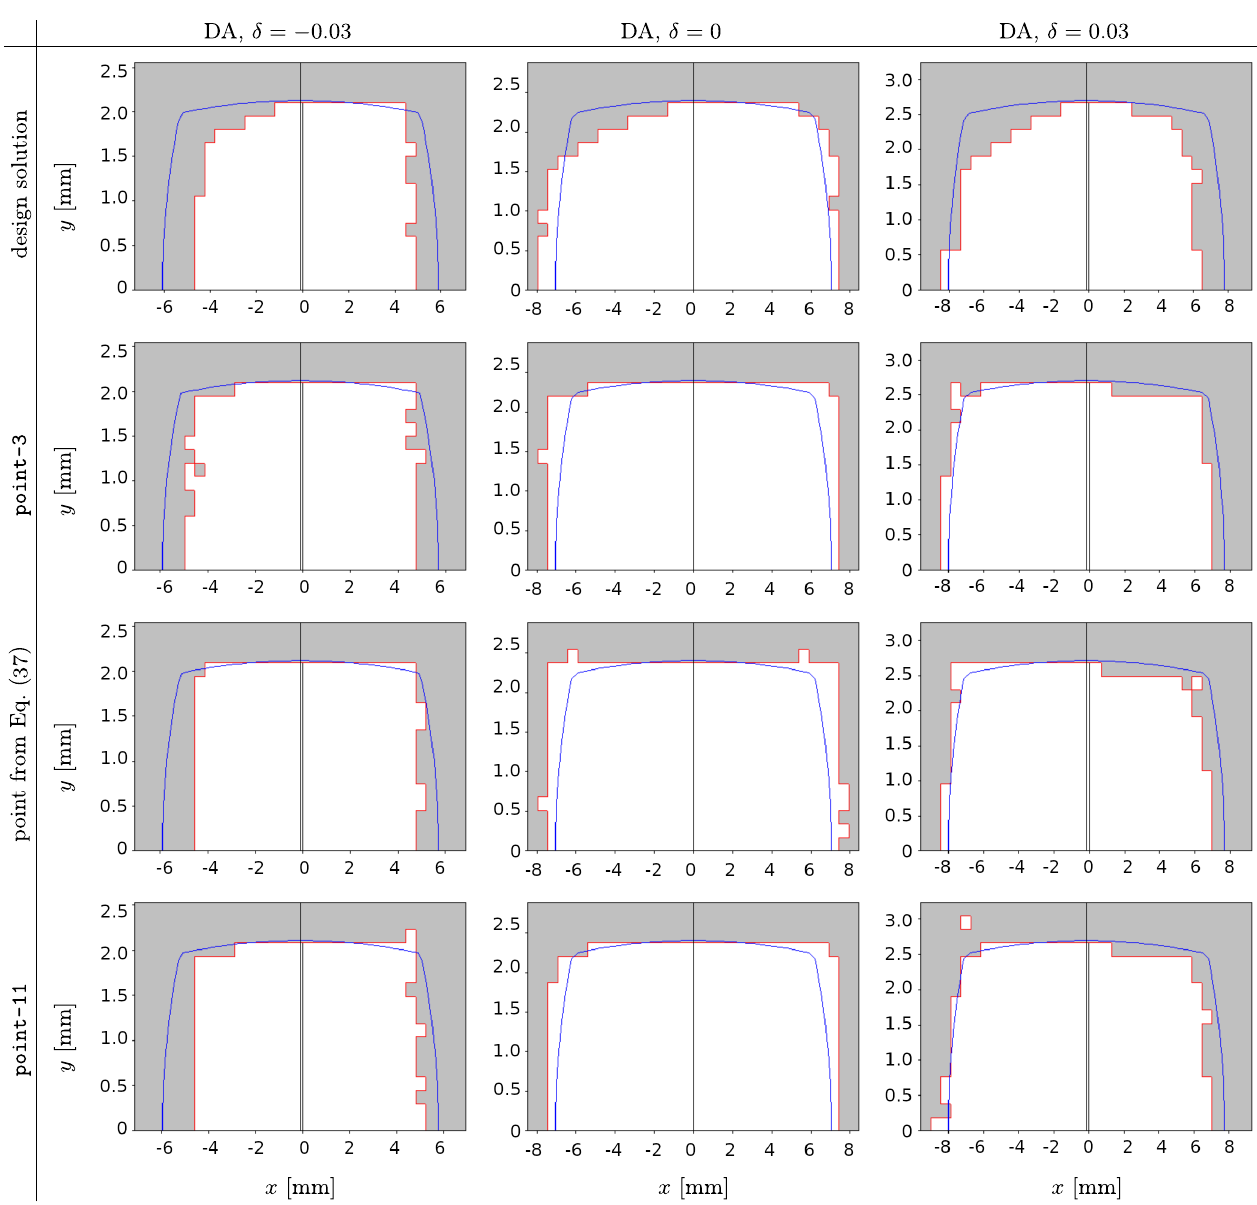
FIG. 6. The columns show the transverse DAs at δ ¼ − 0 . 03 , δ ¼ 0 and δ ¼ 0 . 03 , recomputed in OPA for the manually obtained solution (referred to as the “ design solution, ” first row), point-3 from Table III (second row), the design point from Eq. (37) (third row) and point-11 from Table VI (fourth row). The particles are tracked for 500 turns on a grid in the transverse plane. The blue silhouette shows the linear aperture limits computed by OPA , assuming elliptical vacuum chamber parts [42]. The results are consistent with the TRACY computation in Fig.